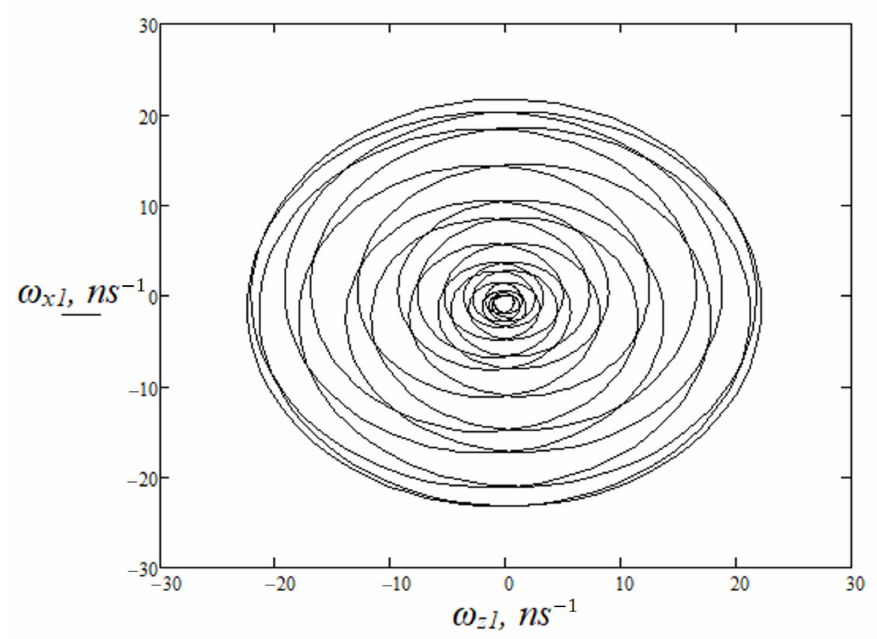
Figure 8. Herpoloid torus with “frozen” fullerenes.